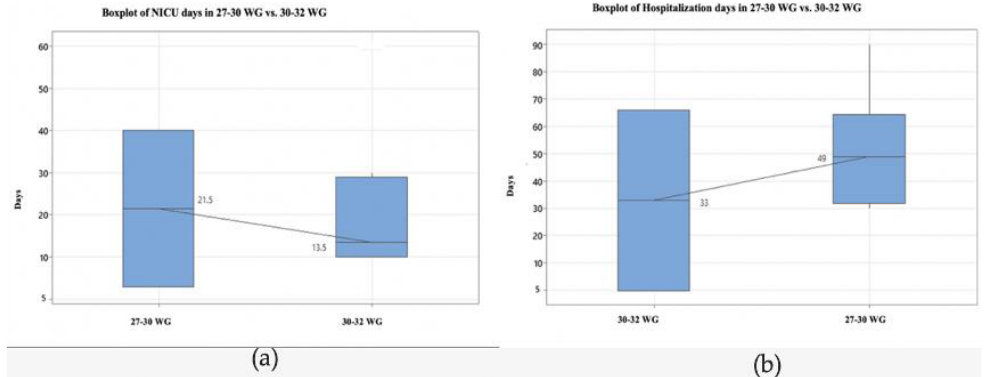
Figure 4. ( a ) The boxplot of NICU days in very early suspected IUGR subgroup vs. in the early suspected IUGR subgroup; ( b ) The boxplot of hospitalization days in the very early suspected IUGR subgroup vs. in early suspected IUGR subgroup. Abbreviations: GA gestational age, NICU neonatal Intensive Care Unit, WG weeks’ gestation .